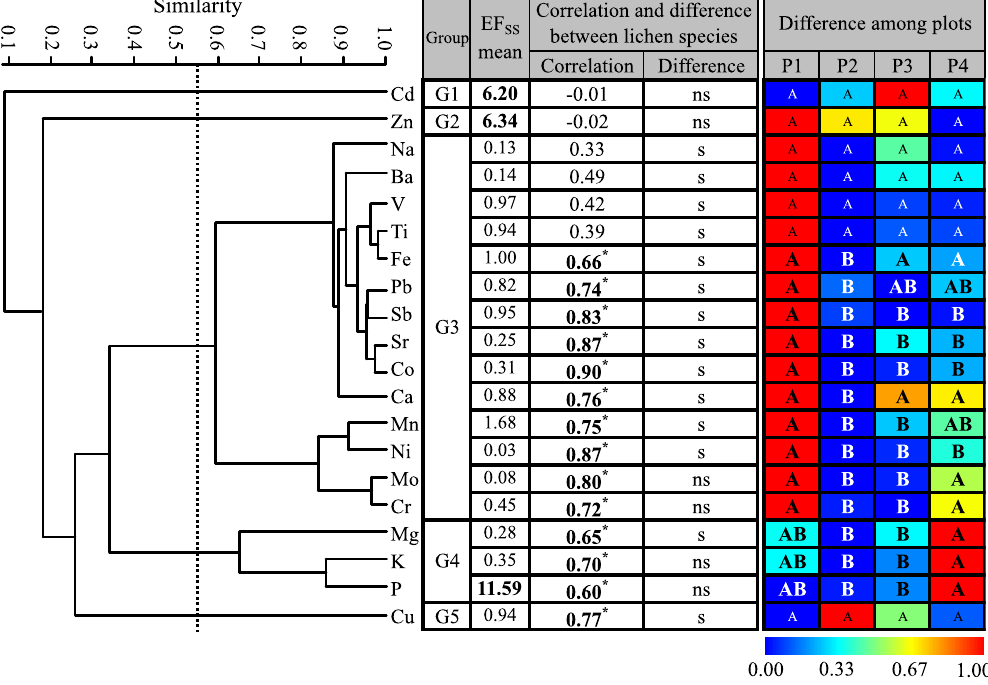
Figure 2. Dendrogram obtained using UPGMA cluster analysis on the correlation distance matrix (left panel) and table showing EF SS and elemental concentration relationships between lichen species and among plots (right panel). The broken line in the dendrogram shows a correlation similarity of 0.55. In the Correlation column, “ * ” denote correlation between lichens are significant at p < 0.05. In the Difference column, “ns” and “s” denote insignificant (p > 0.05) and significant (p ≤ 0.05) difference between lichens, respectively. In the Difference among plots columns, different capitalised letters in a row indicate a significant difference in element concentration among plots. Different background colours in each row are the heatmap showing range-standardised concentrations. EF SS denotes enrichment factor normalised to local surface soil with Fe as a reference element according to Equation 1. P1, P2, P3 and P4 denote plots with a distance from the road of 5–10 m, 100 m, 200 m and 400 m, respectively. Cluster analysis was performed on the raw concentrations (n = 24), and the resultant cophenetic correlation index is 0.896. Concentration correlation and difference between lichen species were performed on raw concentrations using Pearson correlation test and Paired- samples T test, respectively. Concentration differences between plots were evaluated using Paired-samples T tests, followed by a Bonferroni correction ( α = 0.0085). The heatmap was generated using Past 3.14 software (Ø. Hammer, Sep. 2016). All tests were performed on Candelaria fibrosa (n = 12) and Phaeophyscia hirtuosa (n =